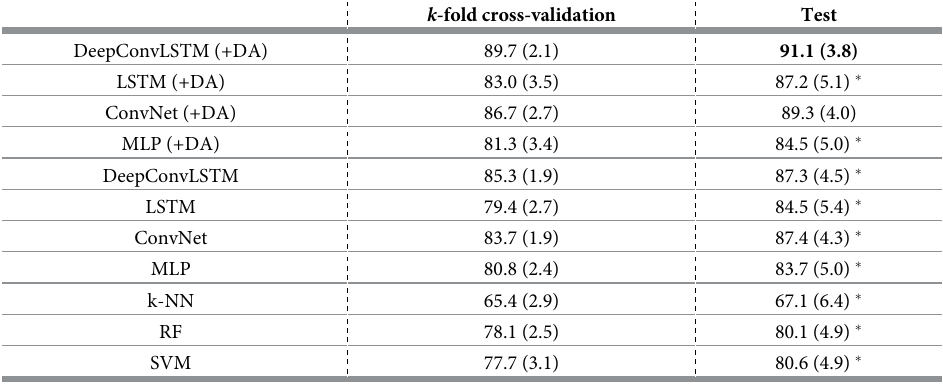
Table 3. Accuracy (Mean (SD)) on the validation and test set for the different models considered (+DA: Include data augmentation). The results include all inner and outer loops of the nested k -fold cross-validation ( � p <